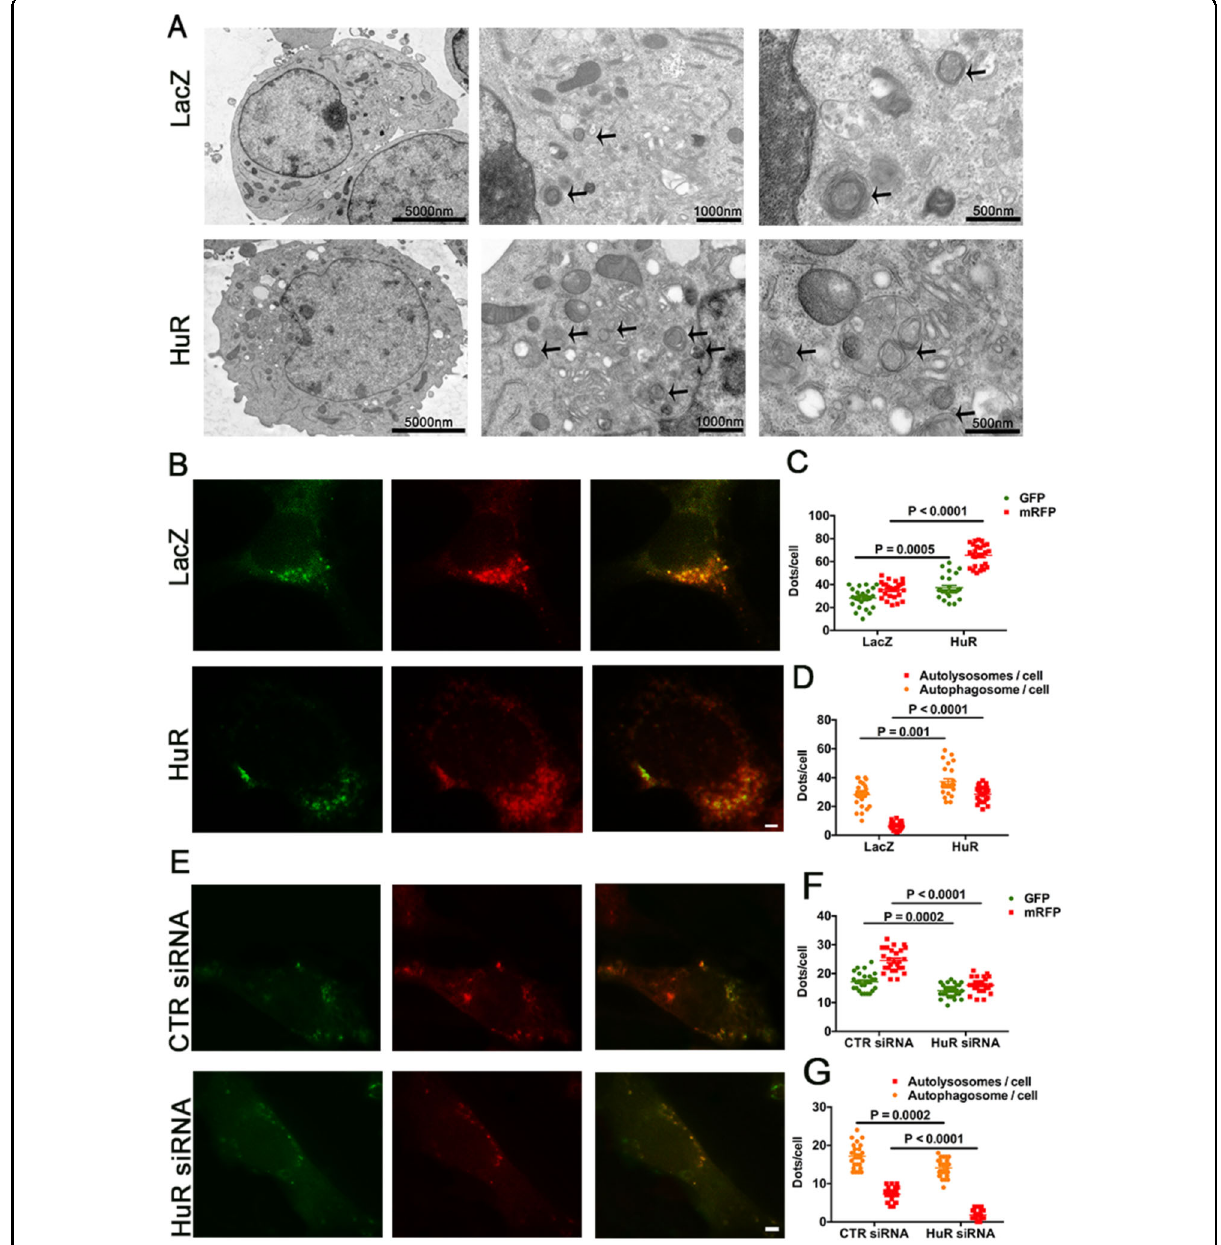
Fig. 4 HuR deletion resulted in defective autophagy. A Transmission electron microscopy of autophagosomes (black arrow) in VSMCs infected with ad-HuR or ad-LacZ. Scale bar = 5000 nm (left), 1000 nm (middle), 500 nm (right). B – D fl uorescence photomicrographs ( B ) and quanti fi cation ( C , D ) of GFP-mRFP-LC3II puncta in VSMCs infected with ad-HuR or ad-LacZ ( n = 26). Scale bar = 10 μ m. E – G Fluorescence photomicrographs ( E ) and quanti fi cation ( F , G ) of GFP-mRFP-LC3II puncta in VSMCs transfected with control or HuR siRNA ( n = 26). Scale bar = 10 μ m. Yellow puncta denotes autophagosome. Red puncta denotes